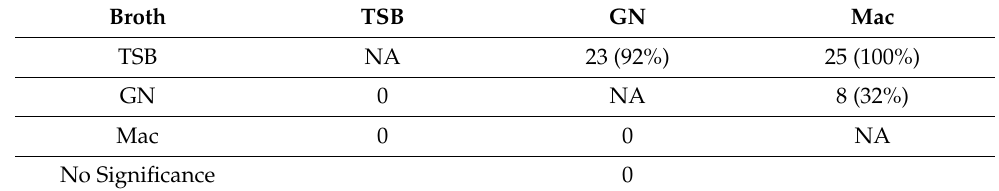
Figure 3. Effects of different enrichments broths tryptic soy broth (TSB), GN, and MacConkey (MAC) on the growth of STEC isolates ( n = 25 isolates) with stool. The bacterial serotype is indicated. Bars represent the CFU/mL calculated from serial dilution plates in triplicate on CHROMagar TM plates. Error bars represent the standard error of the mean. * Growth is significant; ANOVA p ≤ 0.05. Table 3. Percentage of isolates with significantly different growth in each broth with stool ( n = 25). Broth